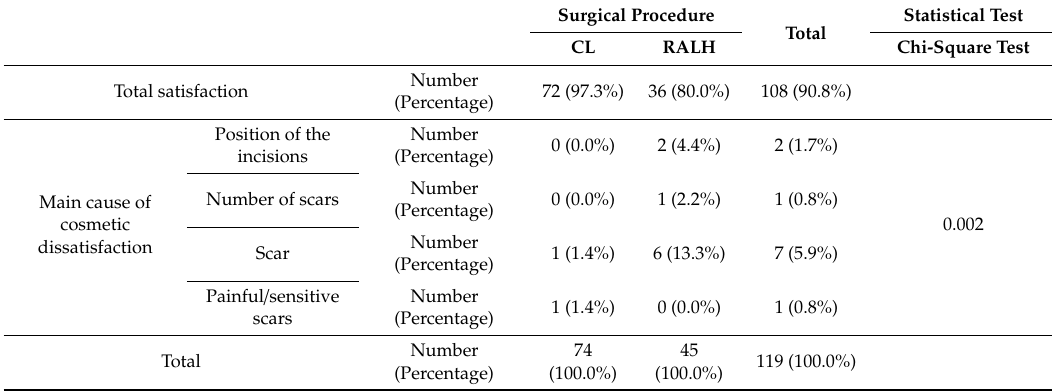
Table 5. Satisfaction- and dissatisfaction- score with the abdominal incision.